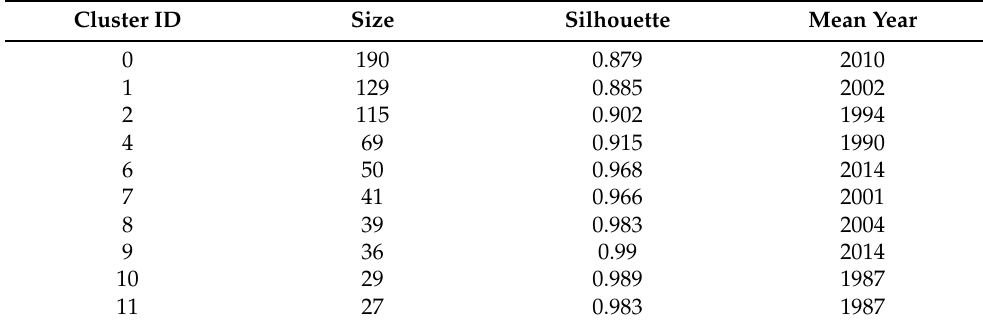
Table 1. Metrics of the 10 largest clusters identified by computing the Document Co-Citation Analysis (DCA).